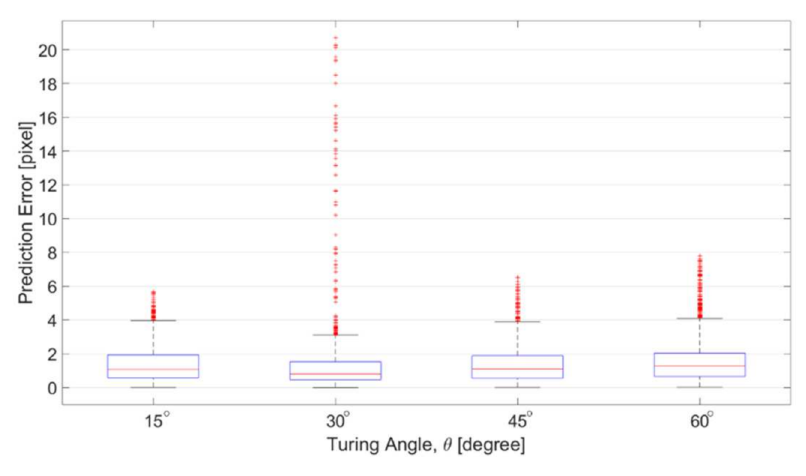
Figure 14. Prediction errors among the channels with different zigzag